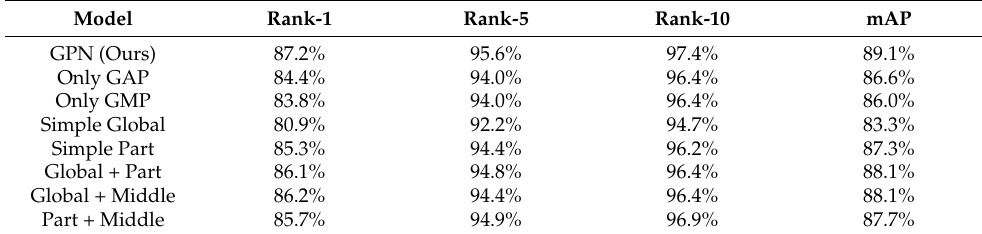
Table 4. Results of different module combinations of the GPN